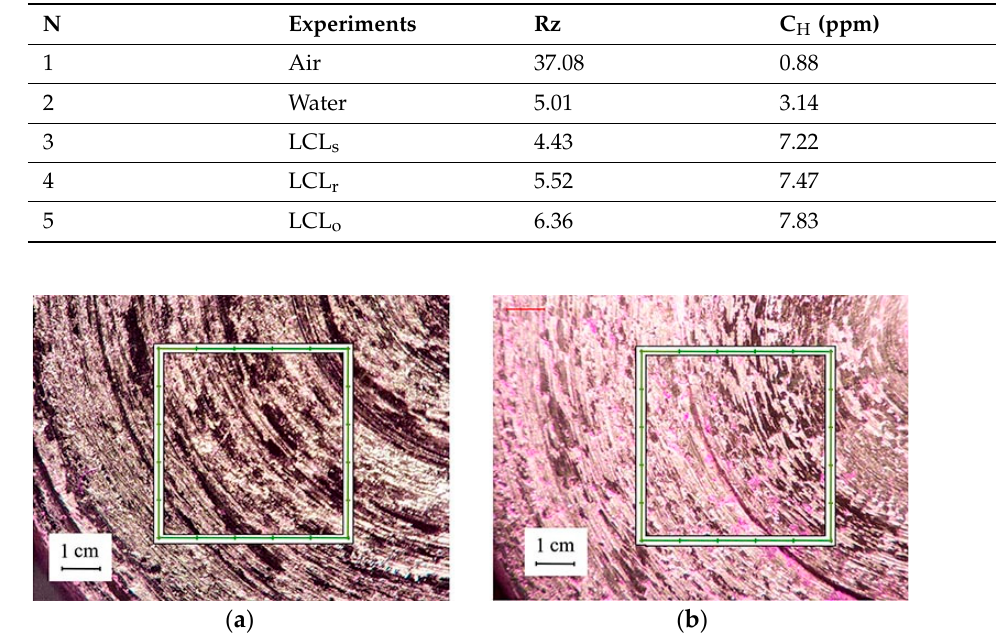
Figure 6. Cutting surfaces of 38Kh Н 3 М F А steel samples: dry ( a ); with water ( b ). The squares indi- cate the areas for the reproduction of 2D and 3D images measuring 5 by 5 cm, depending on the